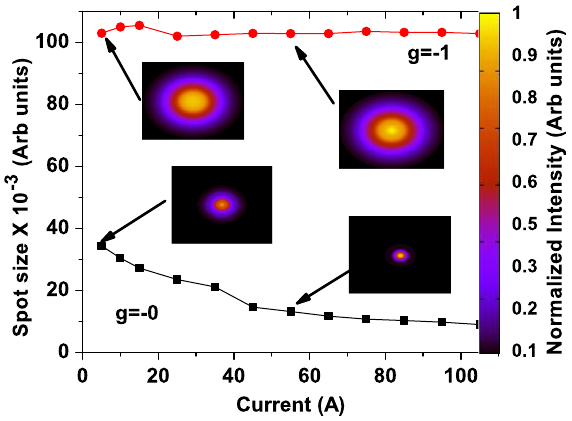
FIG. 3. FWHM of the transverse modes obtained in the simulations, at a wavelength of 10 μ m, as a function of electron current for the confocal ( g ¼ 0 ) and concentric ( g ¼ − 1 ) con- figurations. Plots of the modes at 5 and 55 A, for the confocal and concentric configurations, are also shown. For each plot the window size is 50 mm by 50